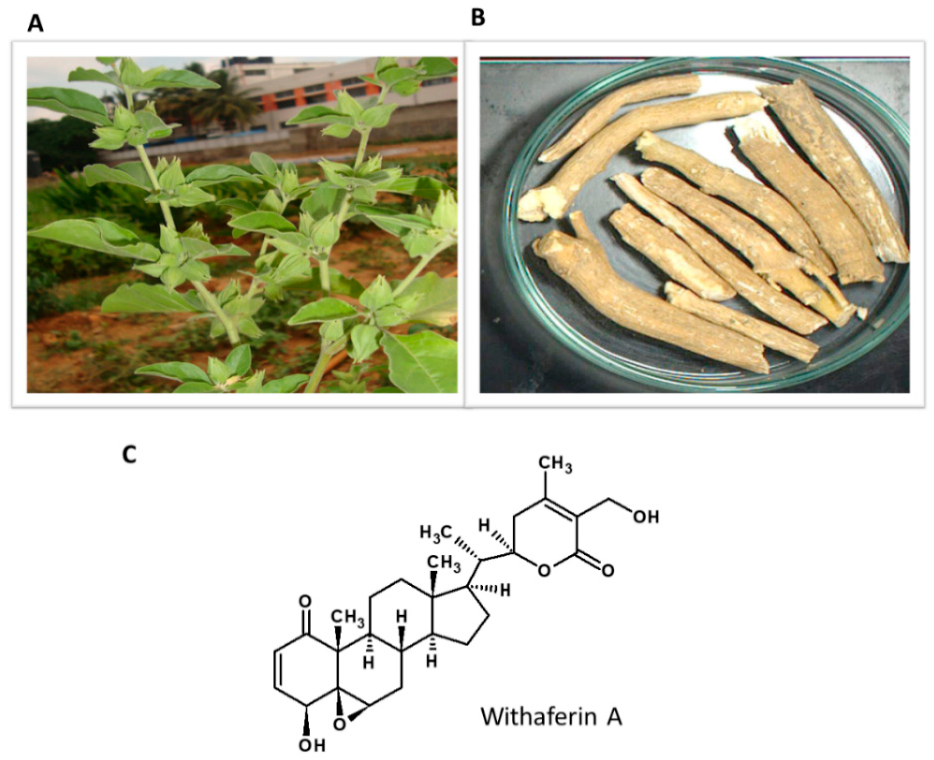
Figure 9. Withania somnifera . ( A ) Habitat of the plant; ( B ) Dried stem; ( C ) Withaferin A. Investigations to identify molecules that can alleviate leptin resistance is an under-explored area for controlling obesity. In an elegant experiment, Liu et.al. used a connectivity map using Endoplasmic reticulum (ER) stress reduction as a tool to identify small molecules which can act as leptin sensitizers, and identified Celastrol, a pentacyclic triterpene extracted from the Tripterygium wilfordi plant, as a potent leptin sensitizer [143]. By analyzing a library of small molecules that have mRNA expression profiles similar to that of Celastrol, the same group identified another naturally occurring compound, Withaferin A, as a leptin sensitizer [143]. Withaferin A was reported to be a potent leptin sensitizer,